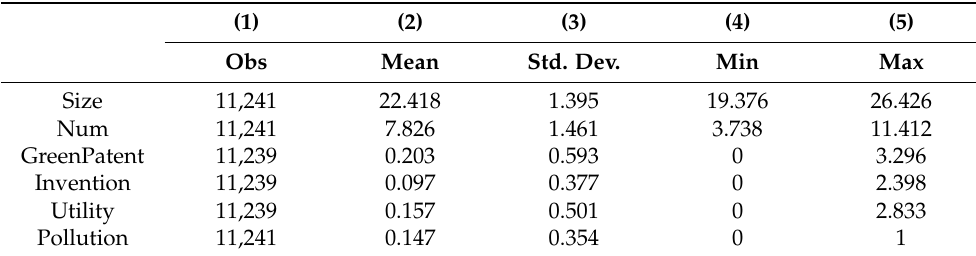
Table 2. Summary statistics of all